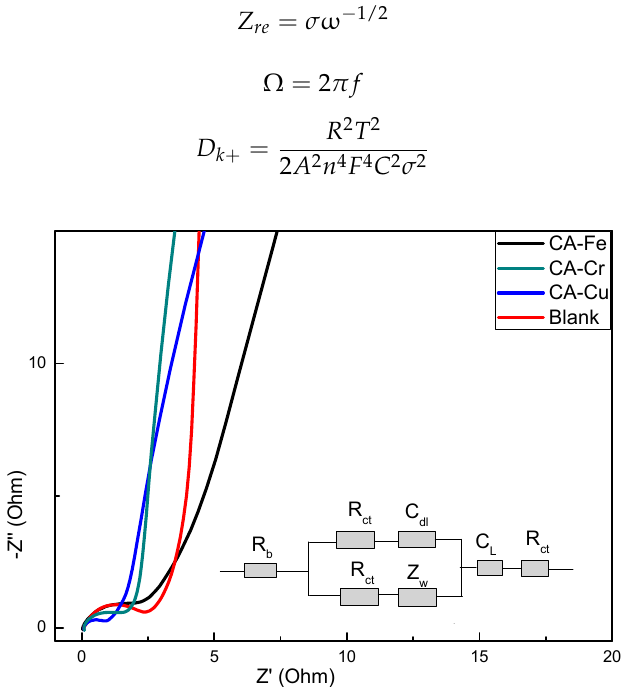
Figure 13. Nyquist plot of CA-X and the blank.